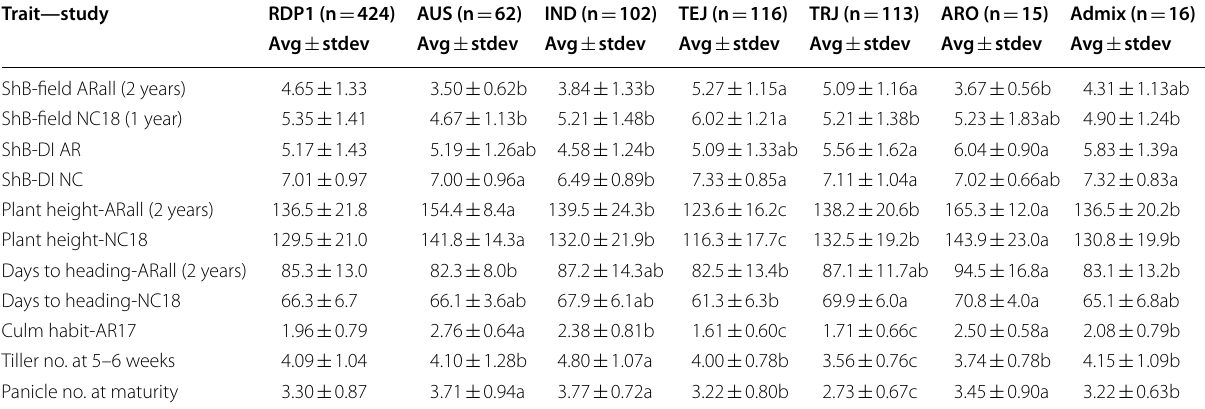
Lowercase letters indicate differences among subpopulation means per trait at the α